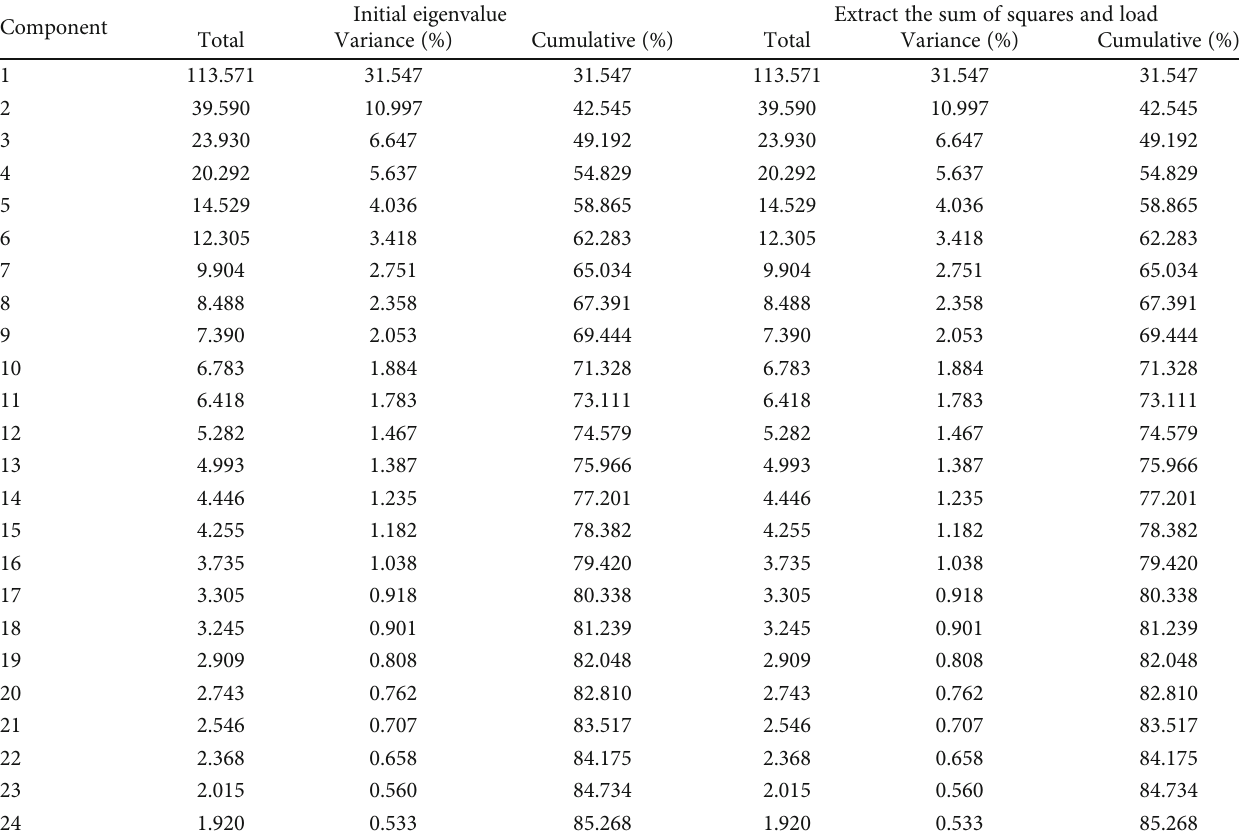
Table 1: Contribution rate and cumulative contribution rate of each principal component.